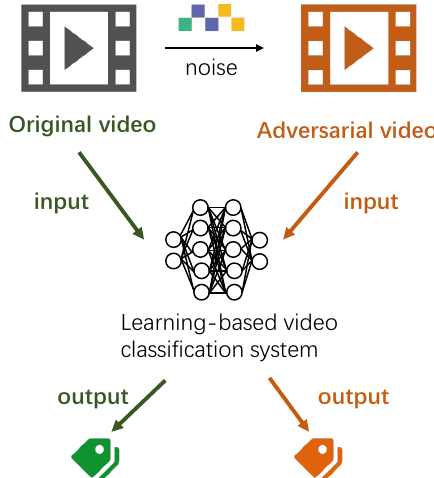
Original label Figure 1. General process of video adversarial example